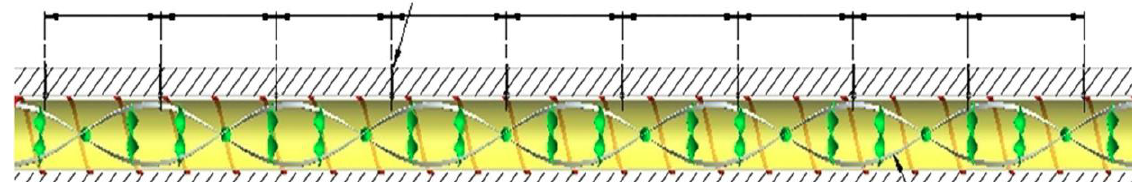
Figure 6: Copper tube with a sparsely placed twisted tape combined with multiple transverse twisted baffles [14]